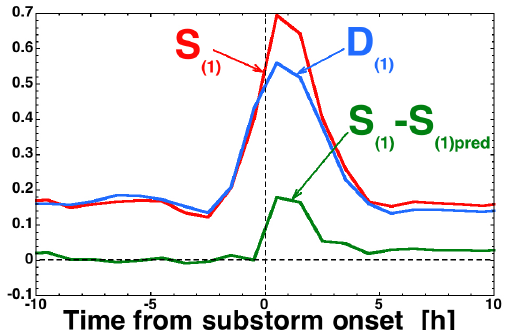
Figure 4. Superposed epoch averages of S ( 1 ) (red), D ( 1 ) (blue), and S ( 1 ) − S ( 1 ) pred (green) for 2155 substorms. The epoch time ( t = 0) is the time of onset of each